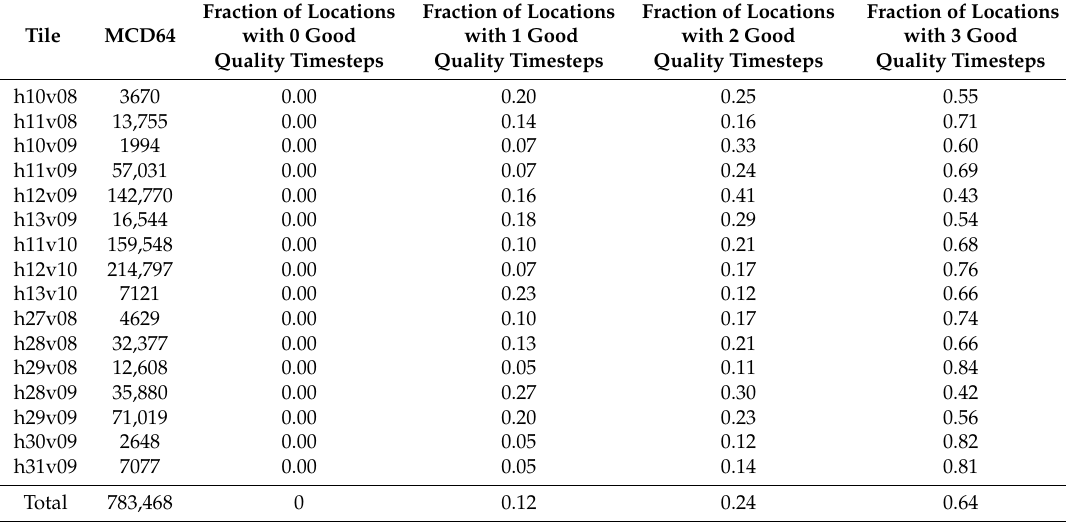
Table 4. Table shows the fraction of MCD64 burned pixels with 0, 1, 2 or 3 good quality time steps out of the 3 time steps from date of burn event